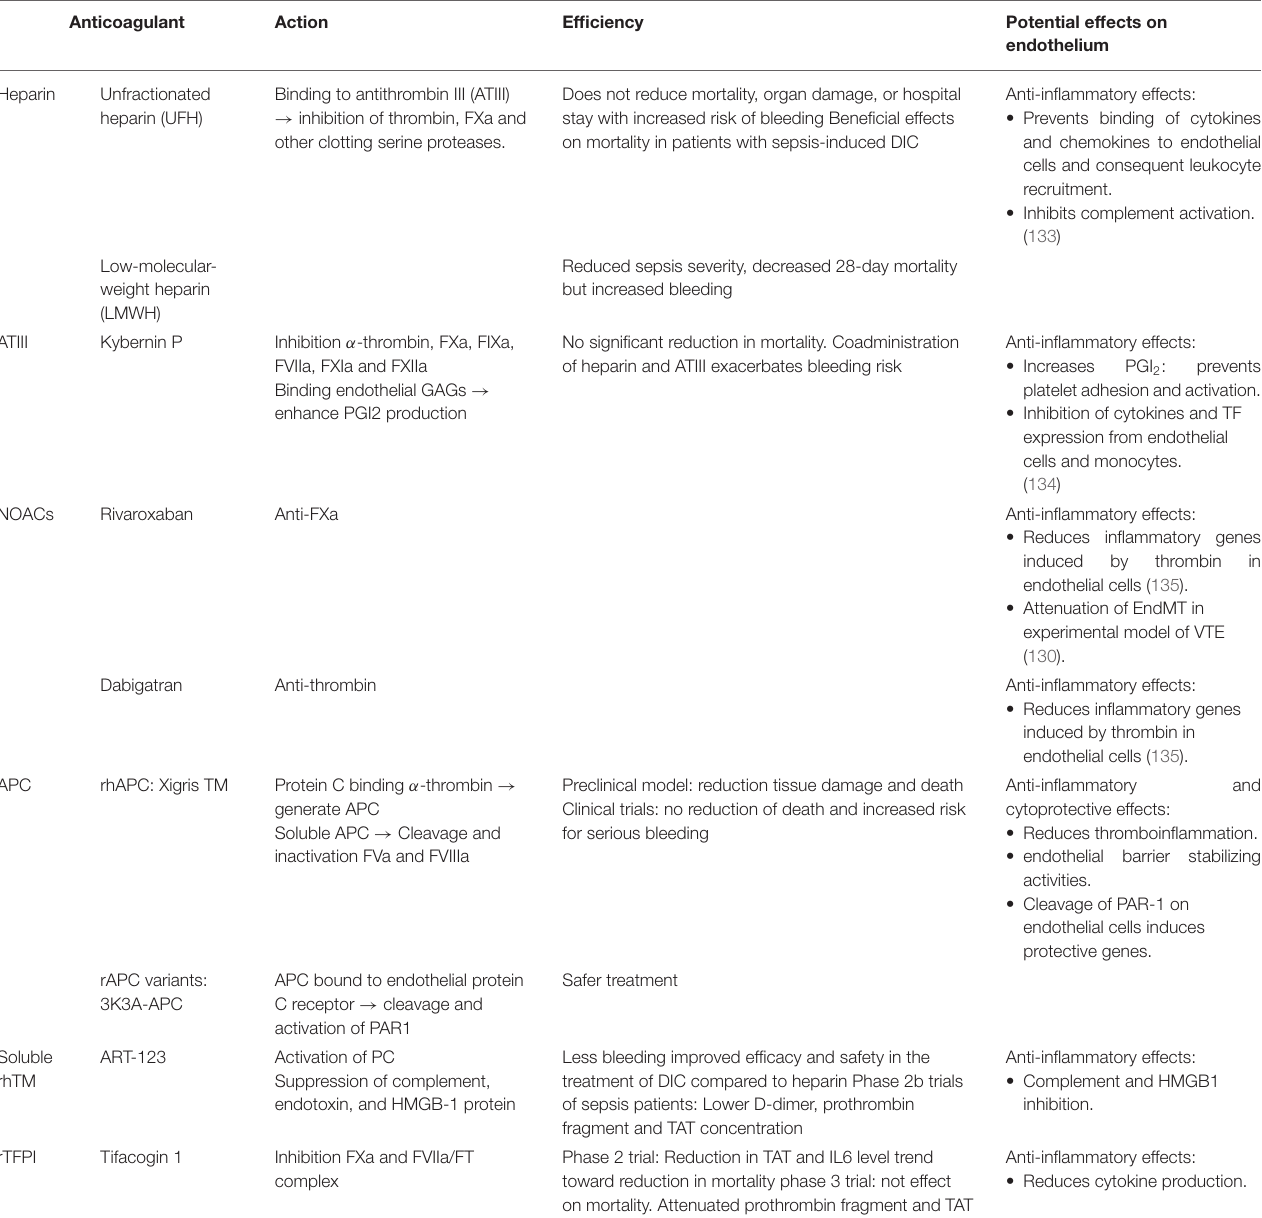
TABLE 2 | Major anticoagulant therapy efficacy, mode of action and potential effects on endothelial function. Anticoagulant Action Efficiency Potential effects on